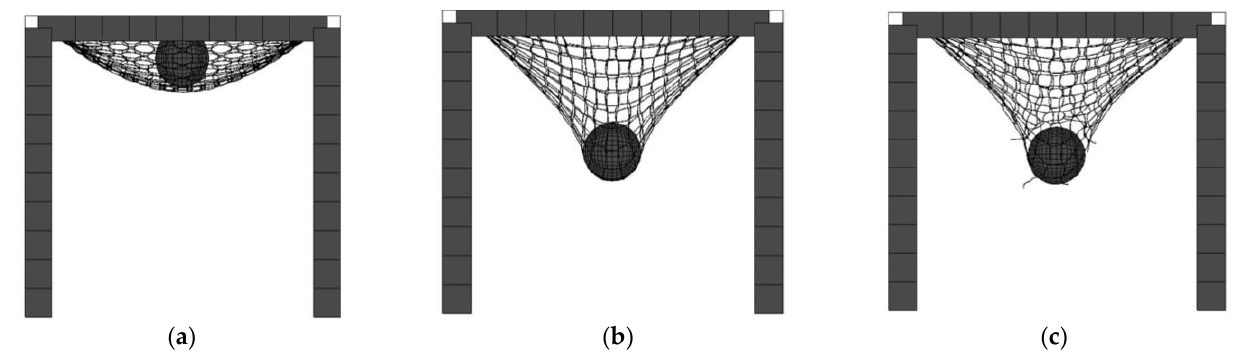
Figure 12. Ring net deformation process in the dynamic impact test: ( a ) ring net relaxation state; ( b ) ring net deformation; ( c ) ring net breakage.